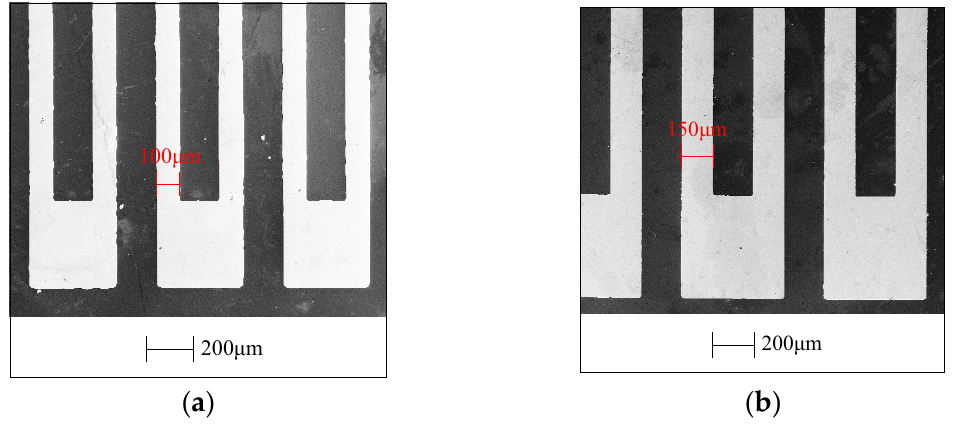
Figure 11. SEM image of thin-film resistor grid sample. ( a ) SEM image of 0.1 mm thin-film resistor grid. ( b ) SEM image of 0.15 mm thin-film resistor grid.